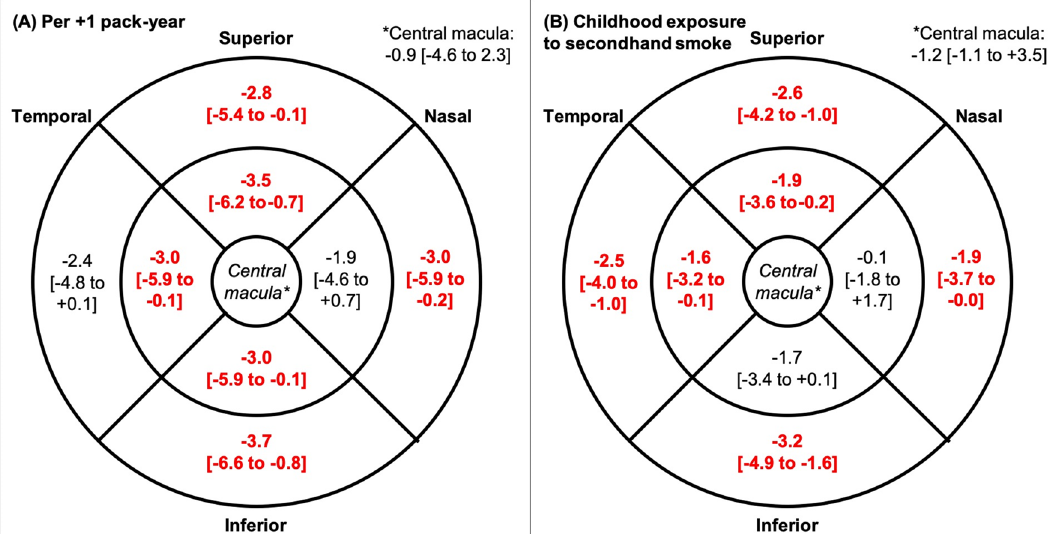
Figure 4. Mean difference [and 95% confidence interval] in retinal thickness (μm) and at the central (0.5-mm radius around the fovea), inner (between 0.5- and 1.5-mm radius around the fovea), and outer macula between (1.5- and 3.0-mm radius around the fovea) with every additional pack-year smoked (A; left) and some or heavy exposure to secondhand smoke during childhood (B; right). Statistically significant positive associations in bold and red ( p < 0.05), corrected for sex, ethnicity, BMI, and ocular